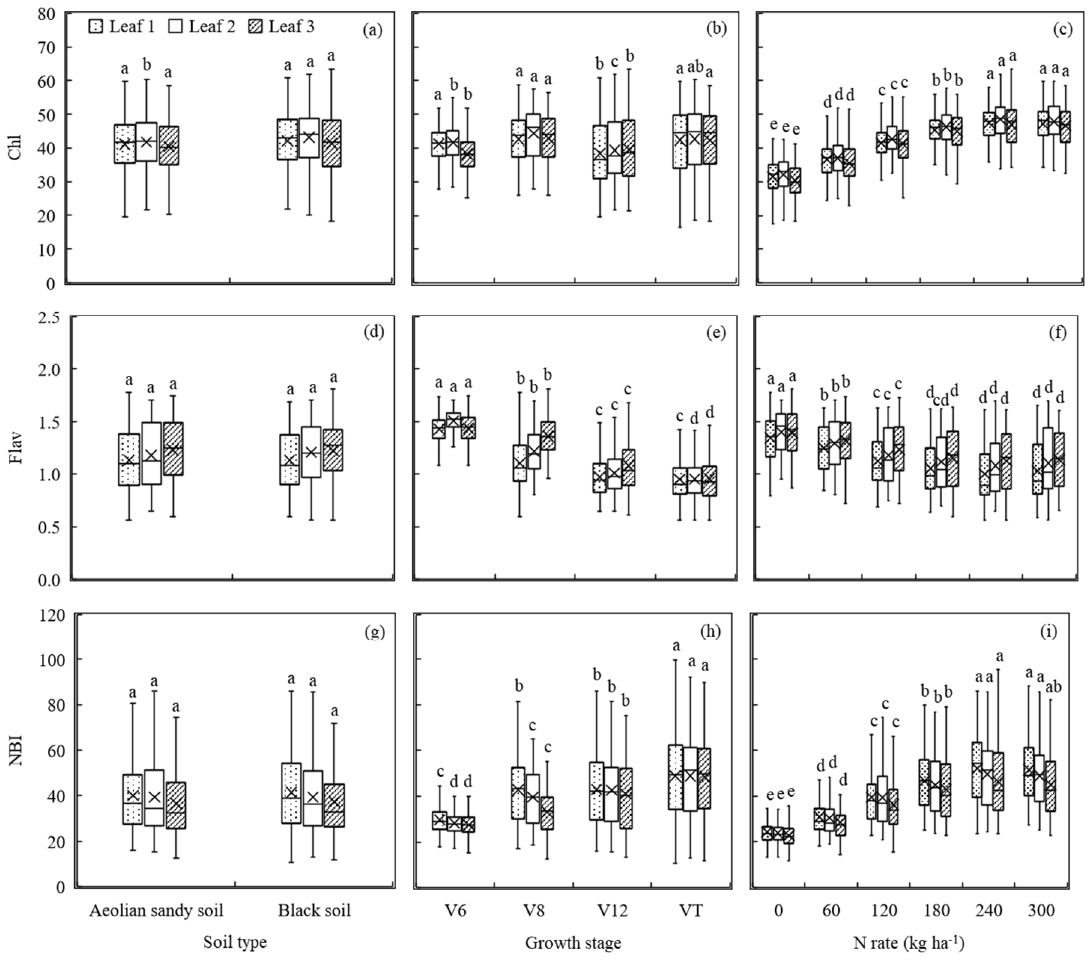
Figure 4. Dualex 4 parameters (chlorophyll concentration (Chl), leaf epidermal flavonoids (Flav), and N balance index (NBI)) as affected by different soil types, growth stages, and N rates. The different letters above the boxes indicate that the Dualex 4 parameter values differed significantly according to the least significant difference test at p ≤ 0.05.